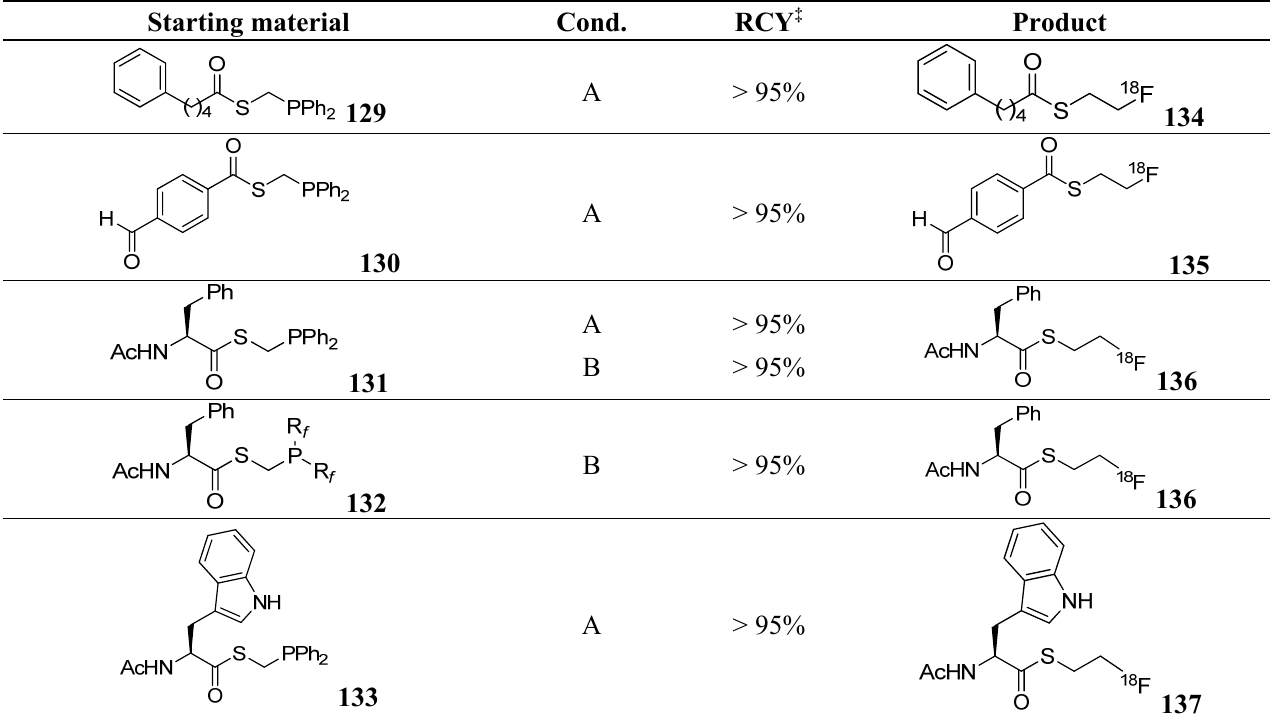
Table 2. Scope of the labeling reaction under Staudinger